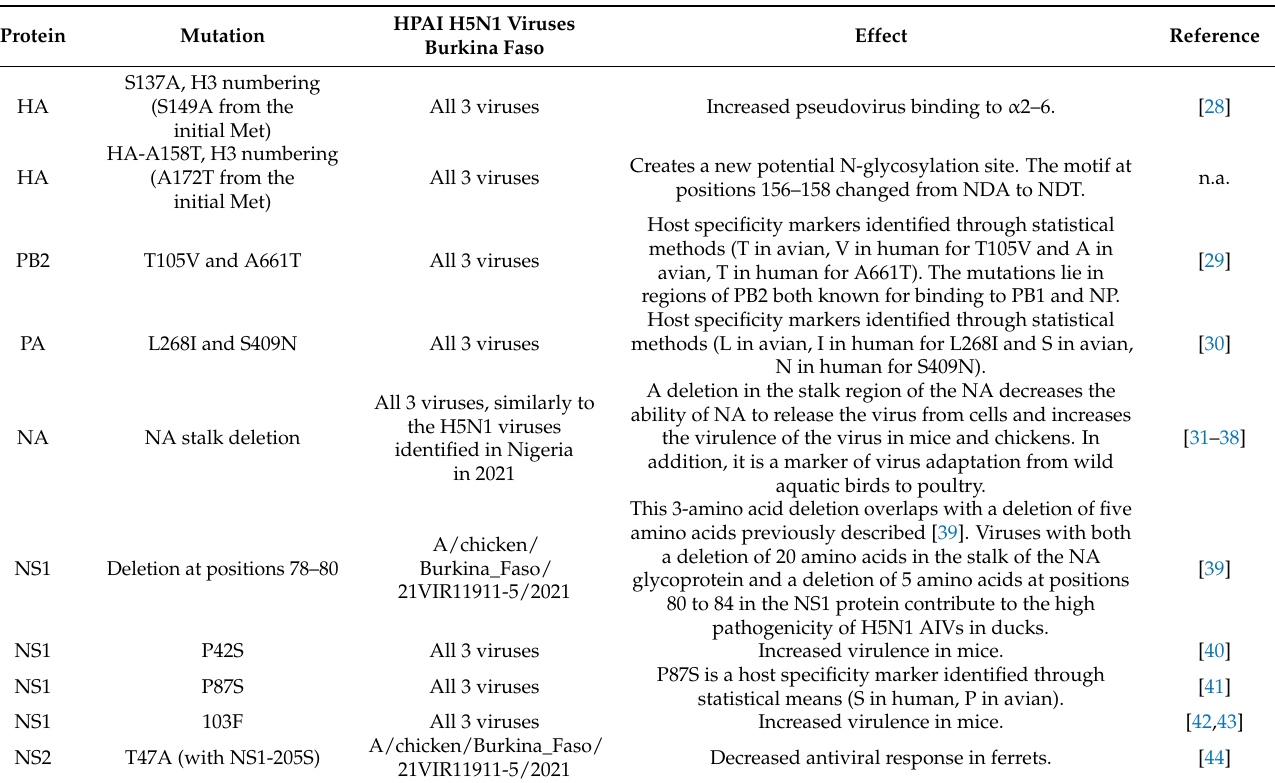
Table 2. Mutations identified in the HPAI H5N1 viruses from Burkina